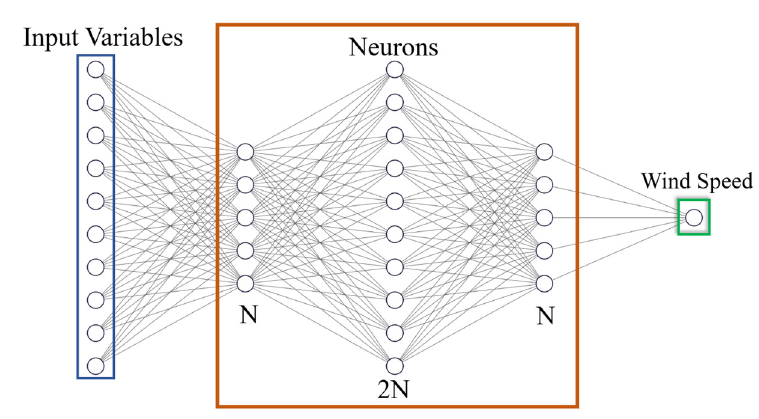
Figure 2. ANN structure adopted in this paper when N = 5. Small circles represent neurons in the model.